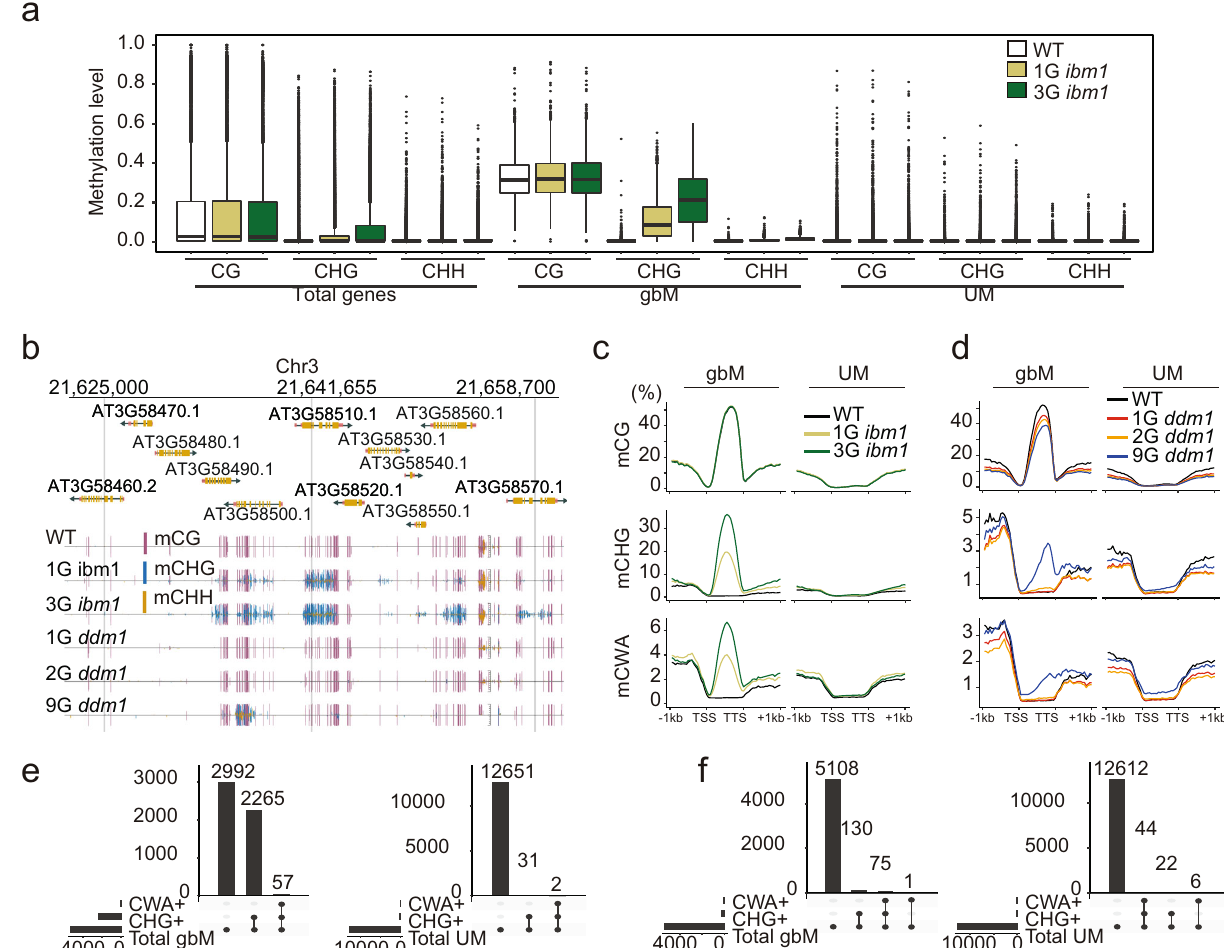
Fig. 1 Ectopic CHG methylation of gbM genes increases over generations in ibm1 and ddm1 mutants. a The DNA methylation patterns of WT (Col-0), 1G ibm1, and 3G ibm1 mutants for all genes, gbM and UM genes ( N = 33056, 5314 and 12684, biologically independent samples in each group of total, gbM and UM genes). Box plots show a median center line, the lower and upper hinges are the fi rst and third quartiles. Whiskers represent 1.5x the interquartile range. b A genome browser view of genes with ectopic non-CG methylation in ibm1 and ddm1 mutants. c DNA methylation patterns of WT (Col-0),